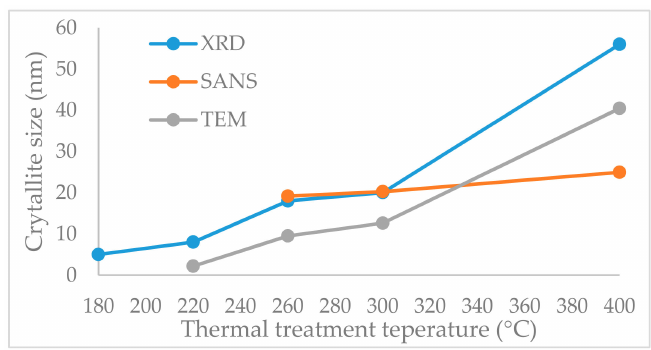
Figure 7. Evolution of the crystallite size for the samples obtained by thermal treatment at di ff erent temperatures.